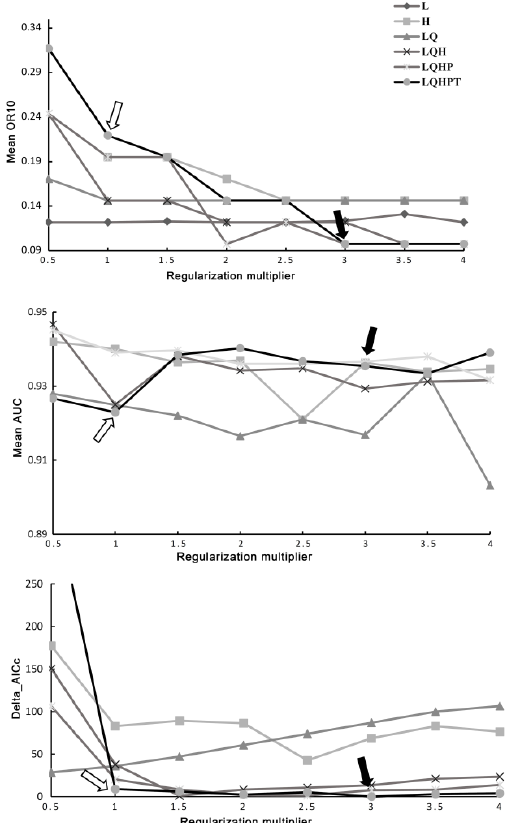
Figure 3. Performances of the maximum entropy model under different settings. The white arrow indicates the MaxEnt default parameter, and the black arrows indicate the parameters of the optimization.